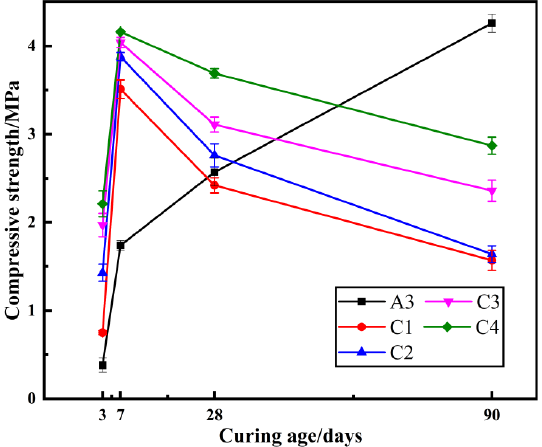
Figure 3. Strength of samples at different curing ages, varying the Na 2 SO 4 dosage.